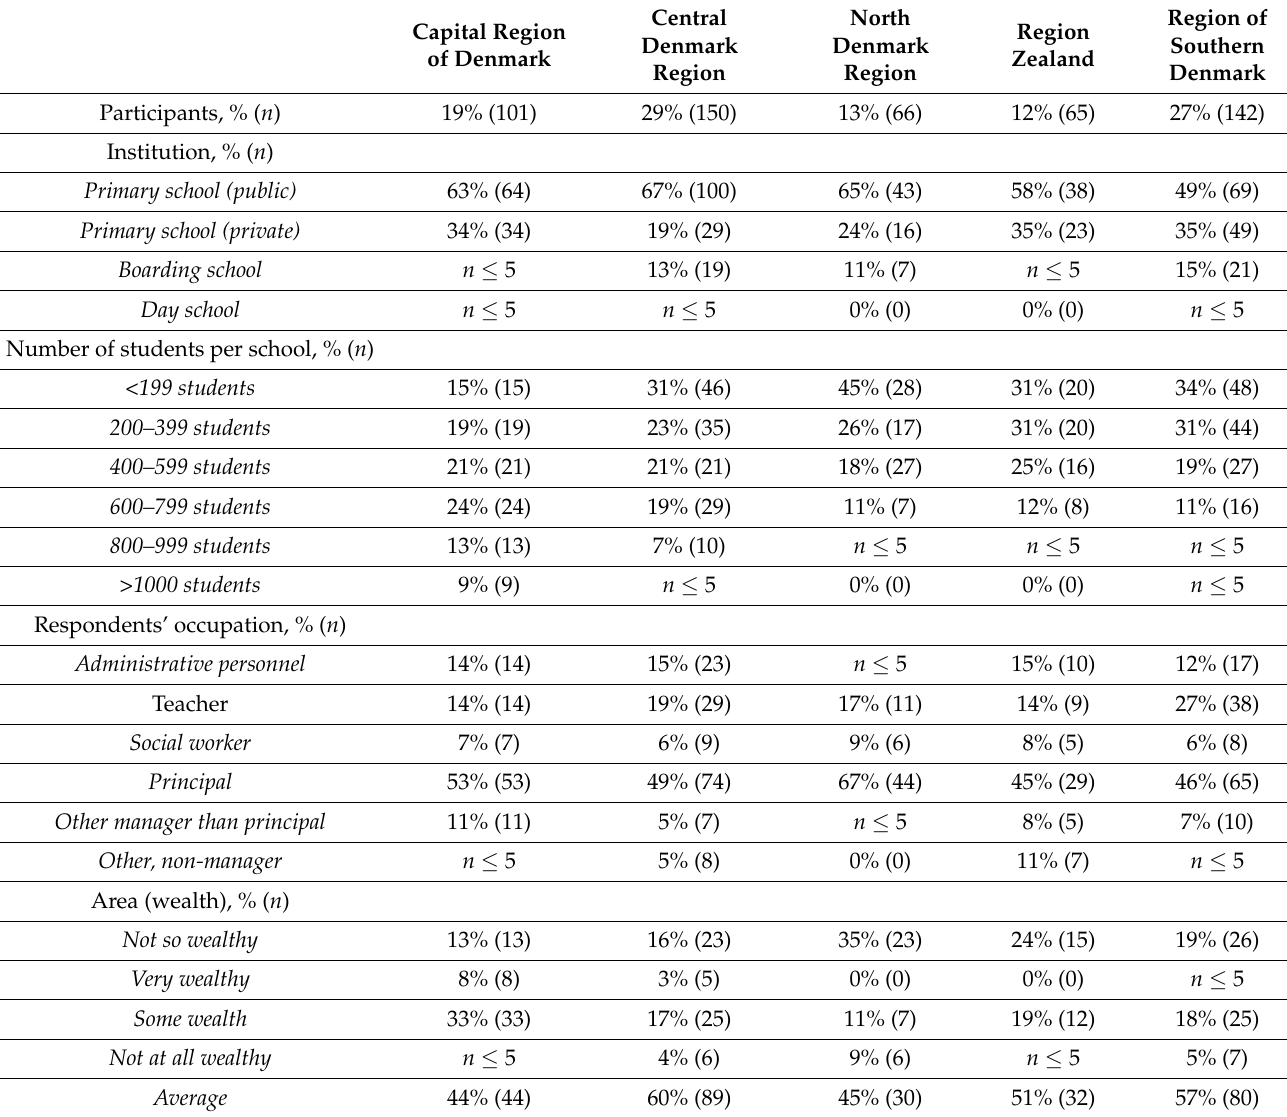
Table 1. Characteristics of participating schools stratified on regional location, n =